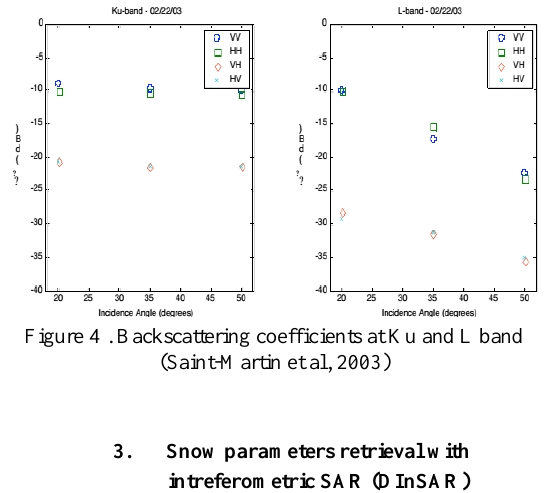
3. Snow parameters retrieval with intreferometric SAR (DInSAR)